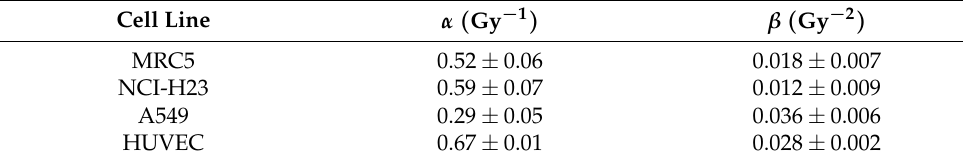
Table 1. LQ-model parameters α and β for homogeneous BB irradiation with 95% confidence bounds.